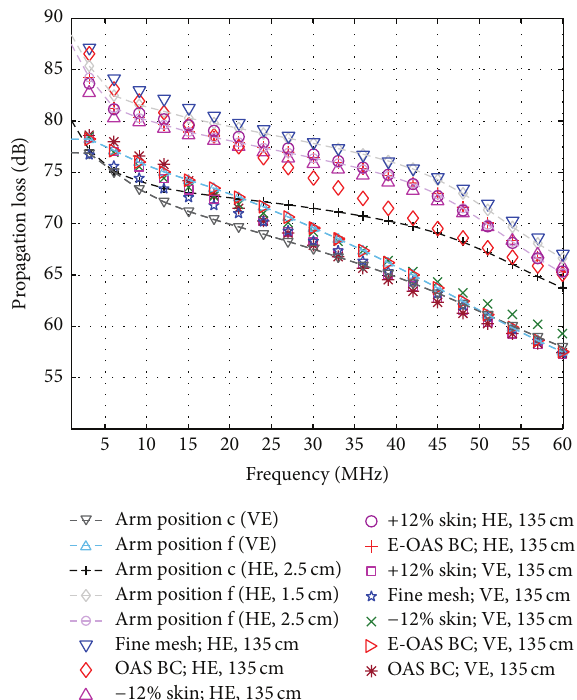
Figure 6: Comparison between horizontal (HE) and vertical (VE) electrode couplers for selected arm positions of Figure 7(b). The effect on propagation loss due to variation of mesh cells, boundary conditions, and skin dielectric properties is shown with coloured symbols for arm position f (135 cm